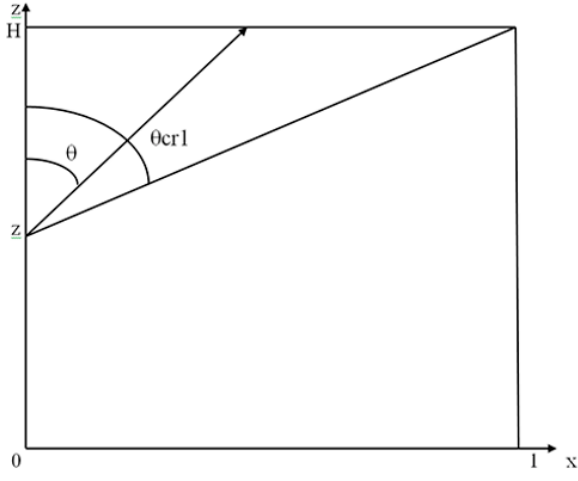
Fig. 8. Scheme of atom departure from the system after collid- ing with the wall.